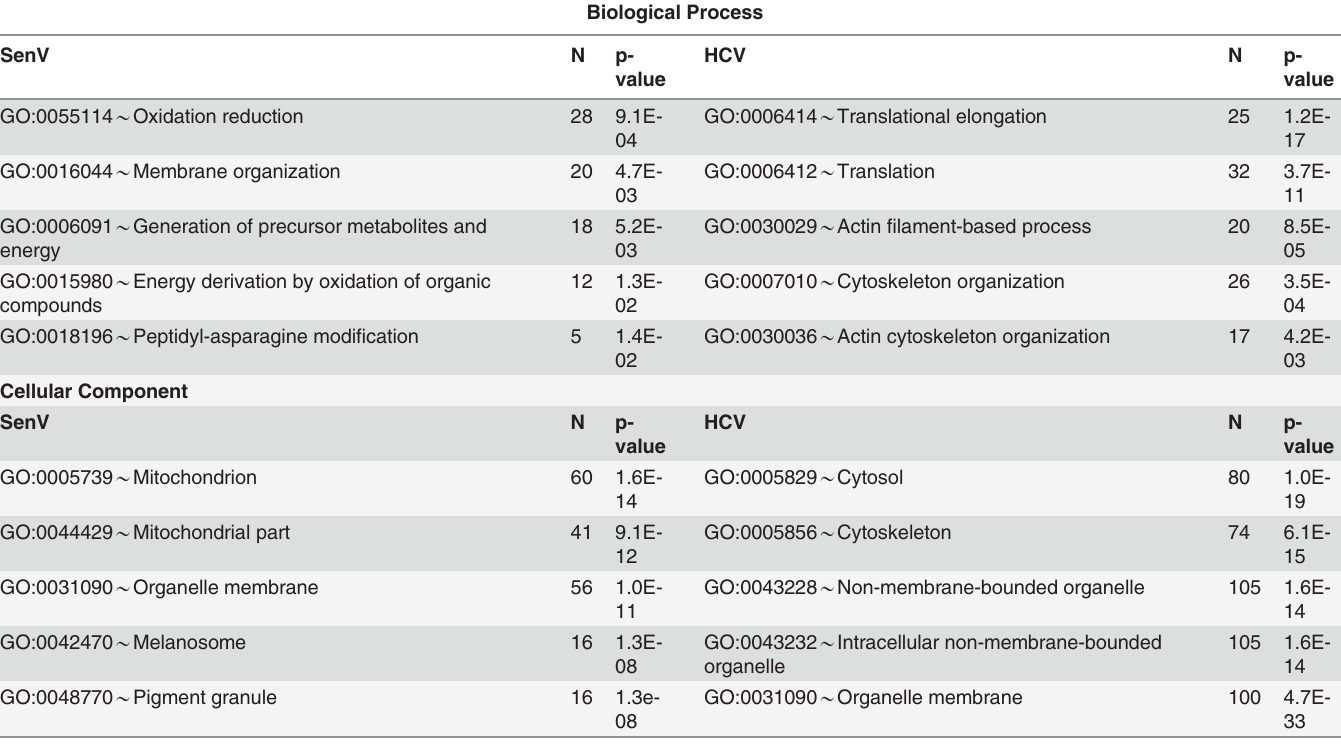
Table 1. Gene Ontology Analysis for proteins that enter the MAM during RNA